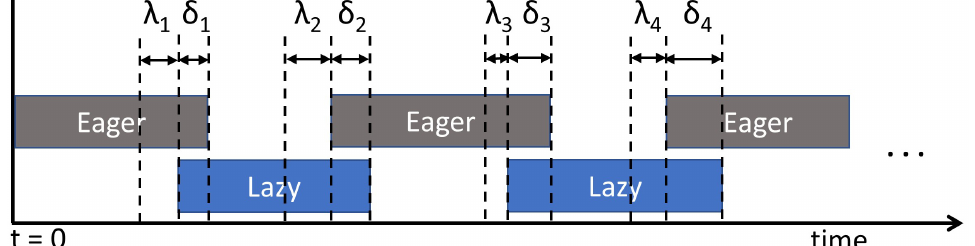
Figure 5. An illustration of the better time barrier design. The interval δ ∗ between Eager and Lazy represents the time taken by in-flight transactions to finish their executions after versioning method is switched. The new transaction that do not conflict with transactions using previous versioning can execute concurrently with in-flight transactions.